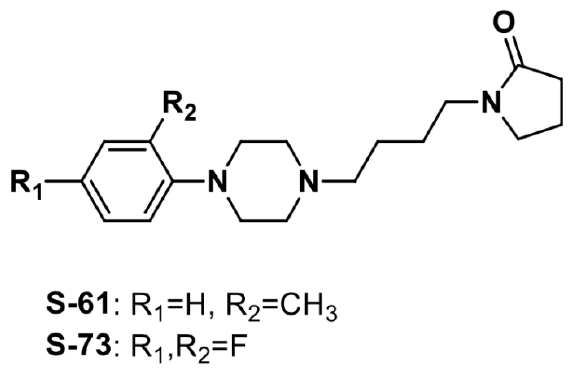
Figure 5. The chemical structure of S-61 and S-73.